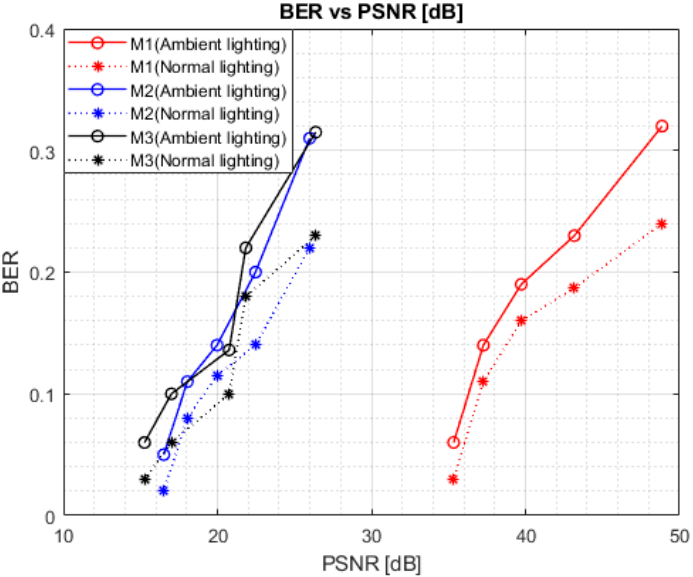
Figure 11. The BER against the PSNR [dB] for the proposed system under normal and ambient lighting conditions.